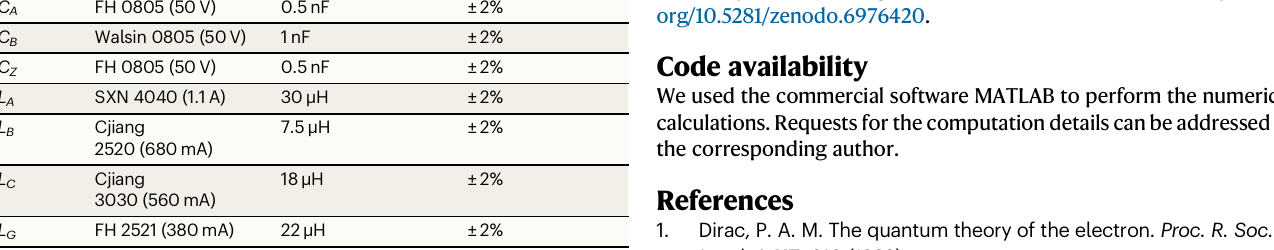
Table 1 | Electric elements used in experiments Electric